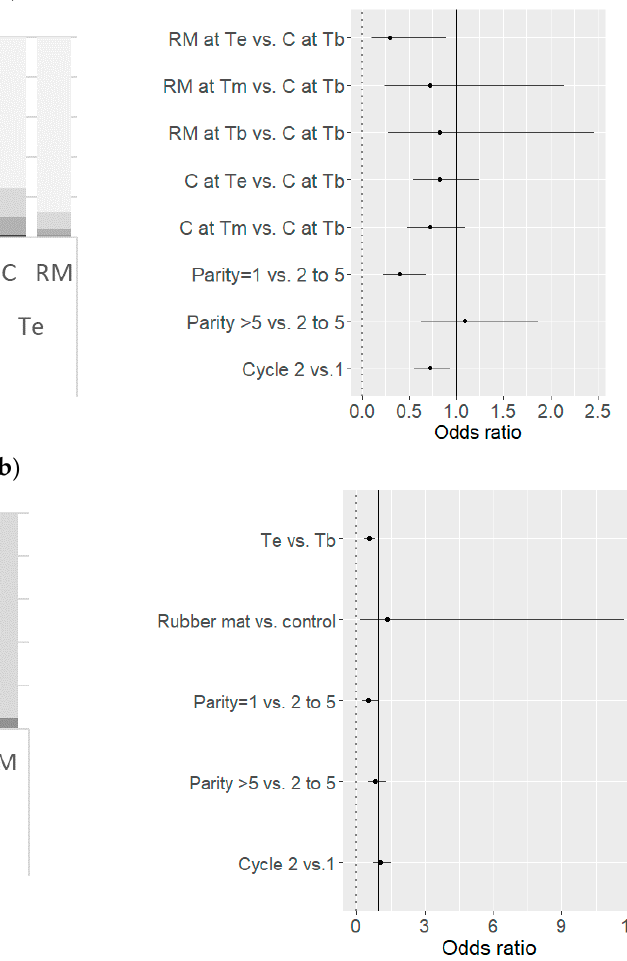
( b ) Figure 5. Distribution of ( a ) claw growth-defect scores, ( b ) claw-erosion scores and estimated odds ratios (with 95% con- fidence intervals) related to mild or severe forms of those conditions according to the floor type and gestation cycle, at the beginning (Tb) and the end (Te) of the gestation period.